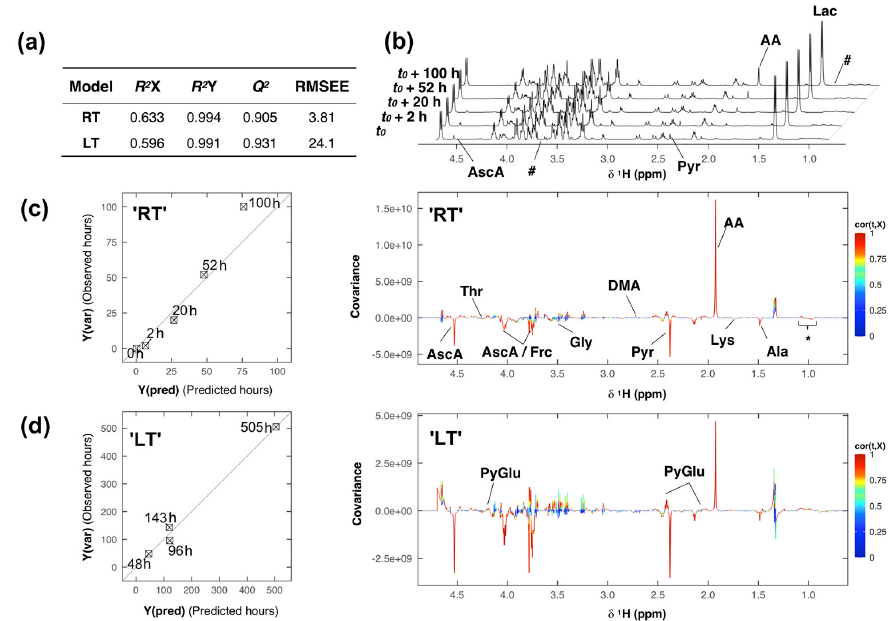
Figure 4. Sample degradation analysis of the room temperature (‘RT’) and low temperature (‘LT’) samples. ( a ) Table of partial-least squares (PLS) model performance and quality parameters. ( b ) 1 H NMR spectra of the ‘RT’ sample acquired at different time intervals. ( c ) (left) Cross-validated predictions for sample ‘RT’, and (right) loading plot derived from the PLS model of sample ‘RT’. ( d ) (left) Cross validated predictions for sample ‘LT’, and (right) loading